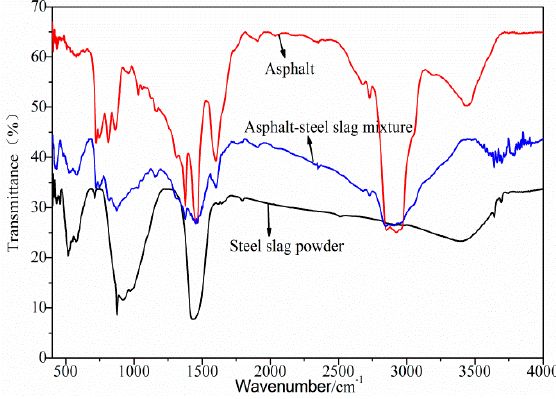
Figure 1. FTIR test results of the asphalt–steel slag mixture. Table 5. FTIR peak wavenumbers of the asphalt–steel slag mixture.